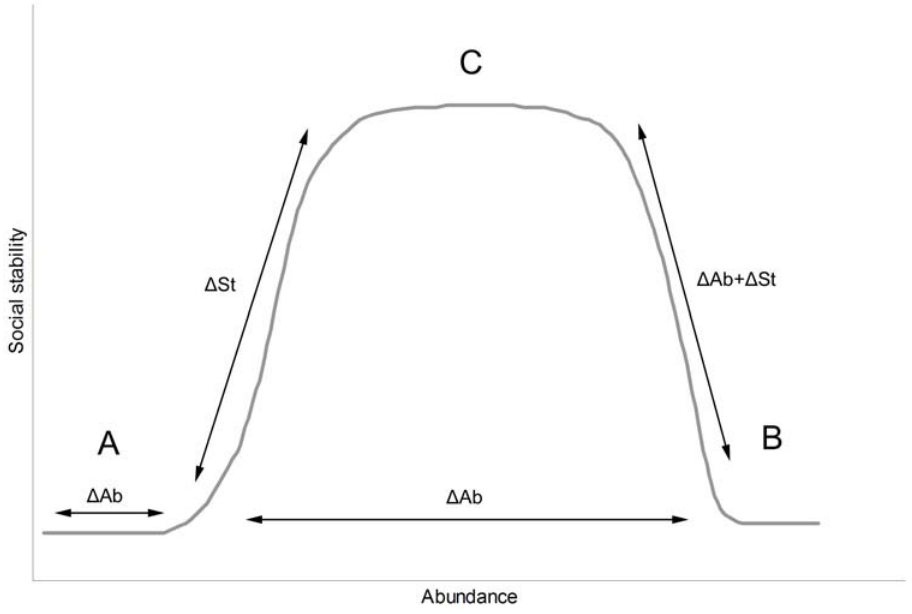
Figure 5. Influence of management on the abundance (Ab) and social stability (St) of dingoes.